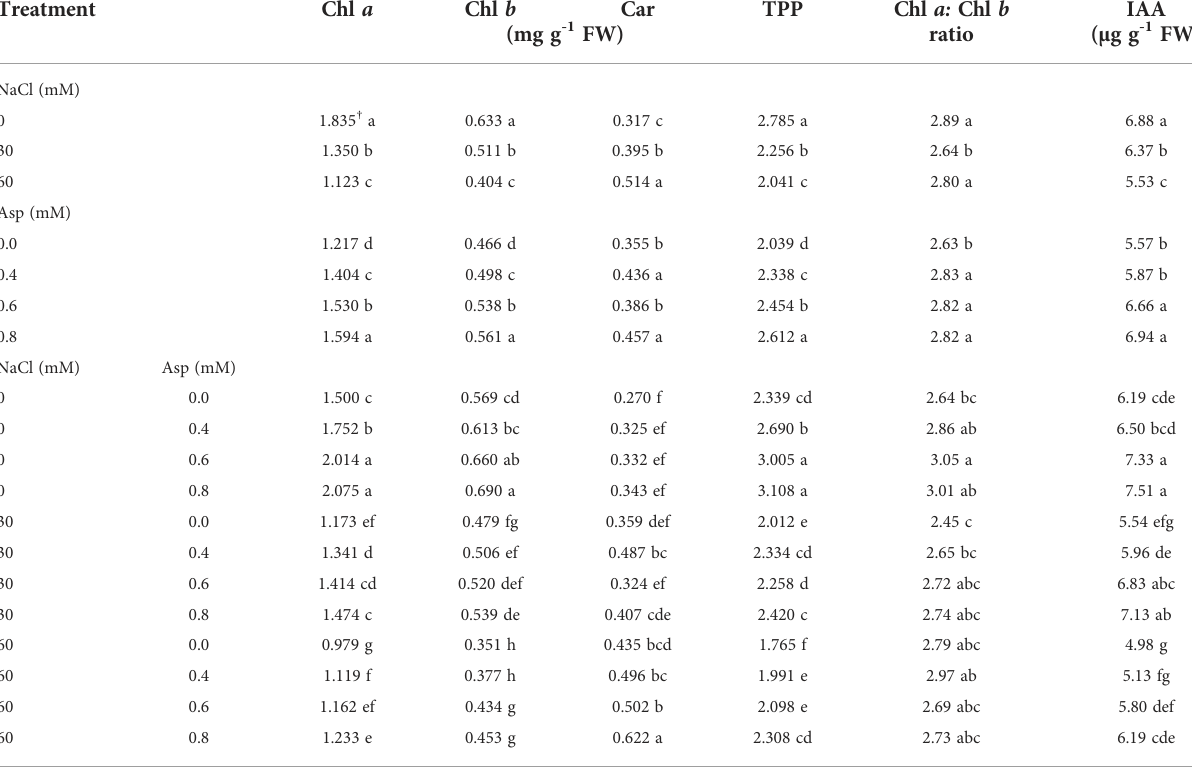
TABLE 1 Effect of aspartic acid (Asp) on chlorophyll a (Chl a ), chlorophyll b (Chl b ), carotenoids (Car), total photosynthetic pigments (TPP), Chl a : Chl b ratio, and indoleacetic acid (IAA) in wheat plants grown under salt stress (NaCl) for 60 days.